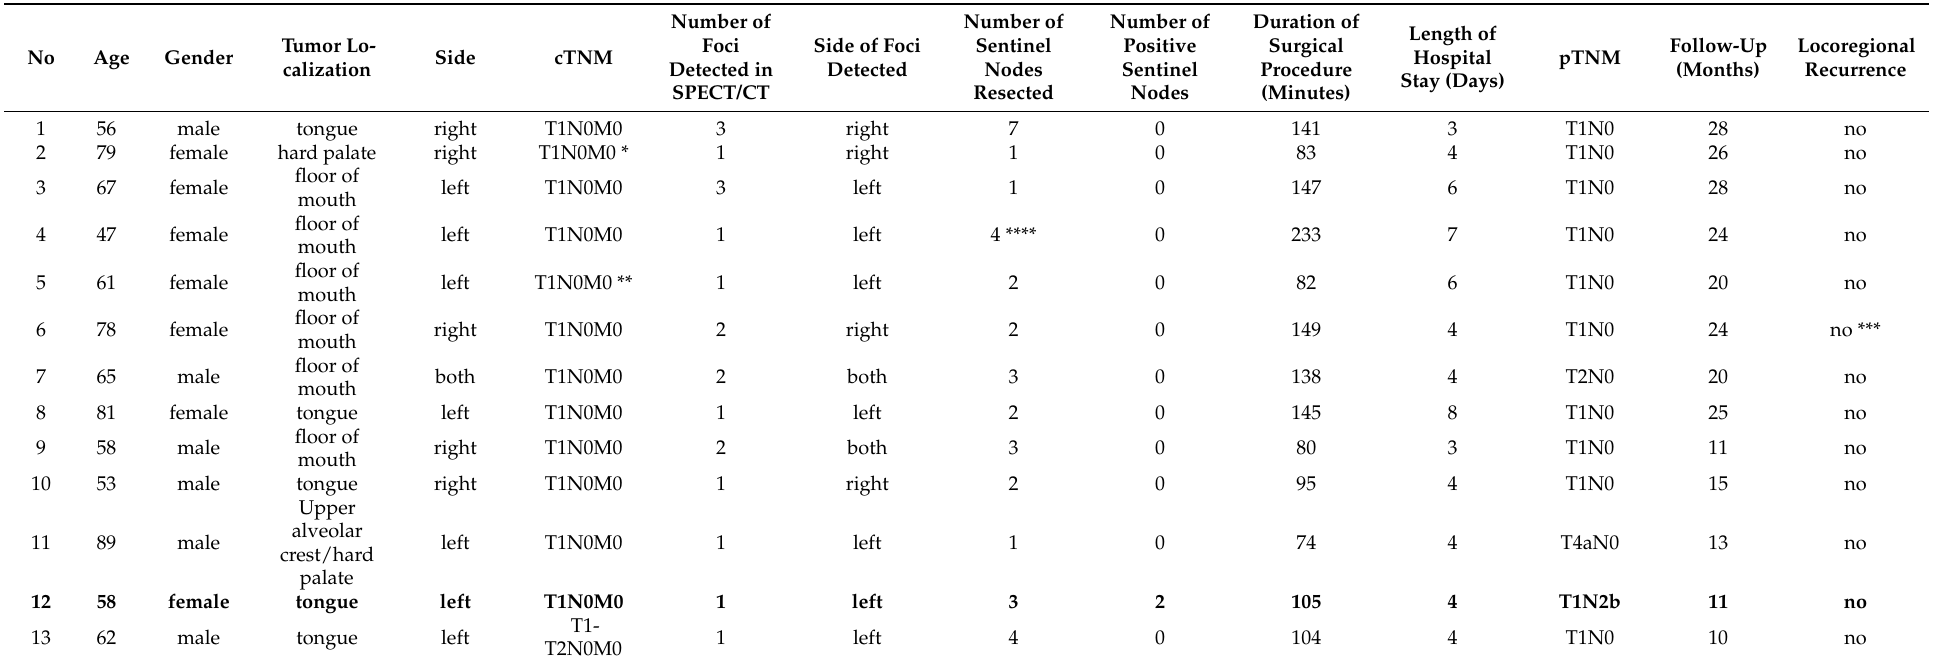
Table 1. Clinical, radiological and histopathological characteristics of the